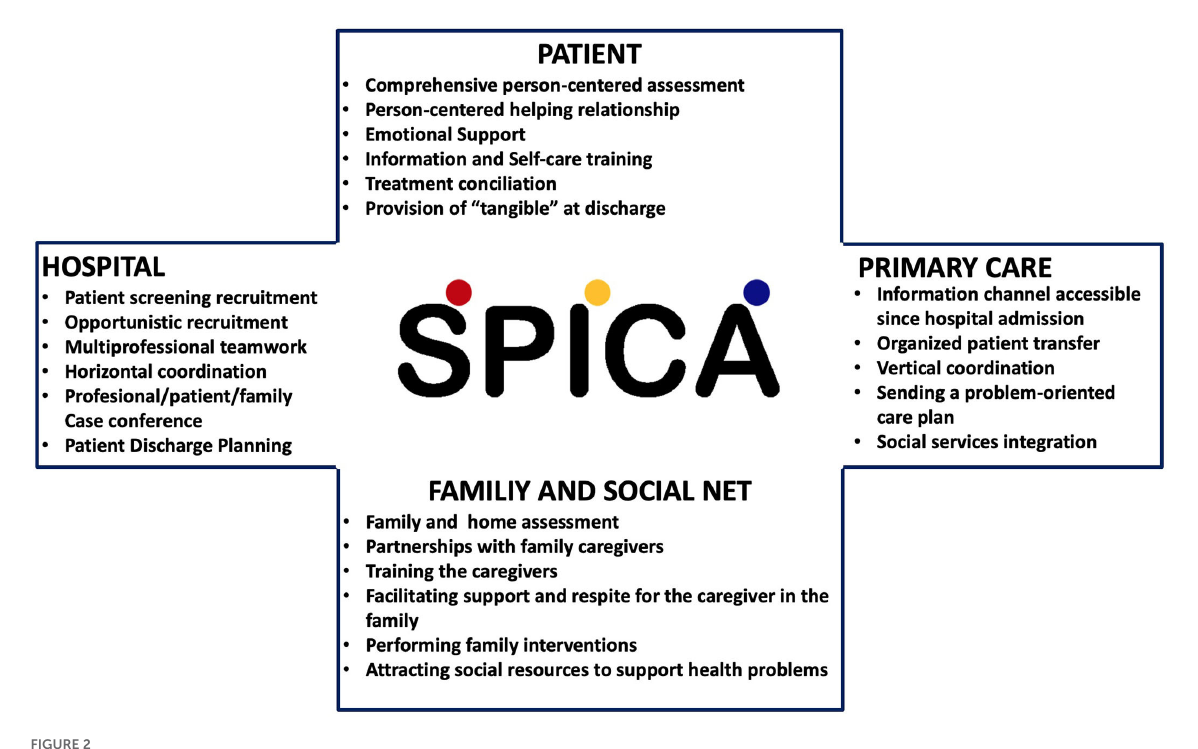
FIGURE2 Main components of the Spica intervention.